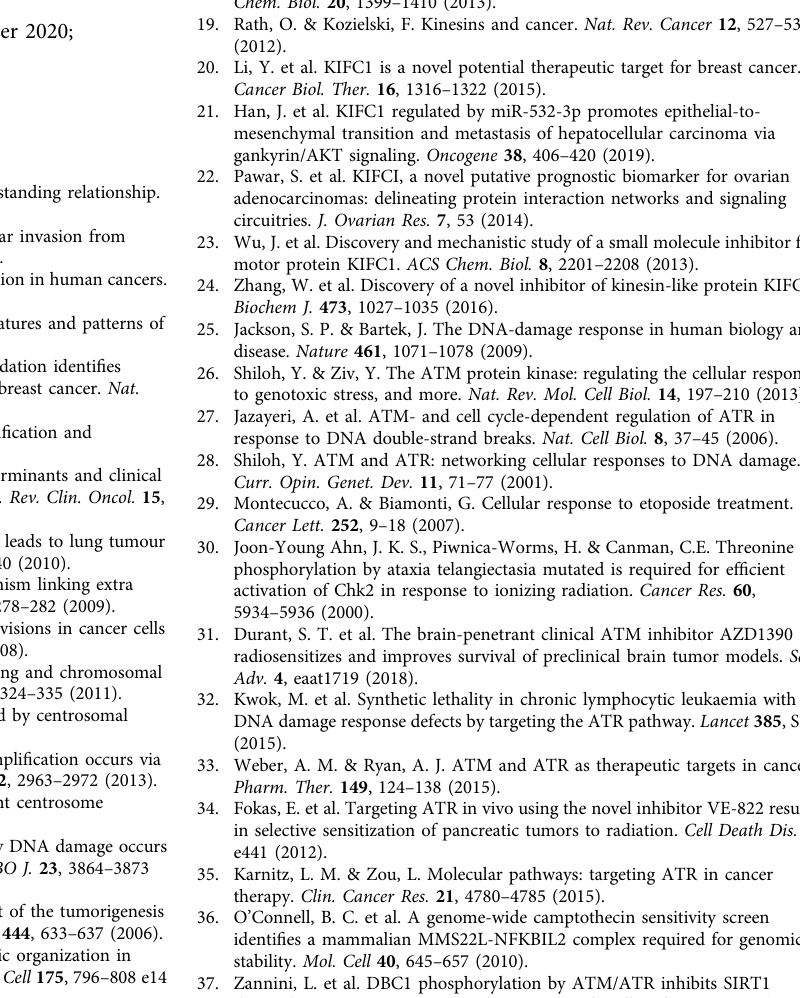
Fig. 8 The ATM/ATR-KIFC1-centrosome clustering pathway promotes tumor recurrence. a Schematic drawing of tumor recurrence, as described in the Methods section. Xenograft tumors were treated with etoposide alone and in combination with PBS, VE-822, or CW069, and were allowed to grow up to a mean volume of 300 mm 3 before being surgically resected. After surgery, the mice were treated with the indicated drugs for another 2 weeks. After 5 months with no drug treatment, mice with tumor recurrence were identi fi ed and analyzed. b The time at which the indicated tumors reached 300 mm 3 . Data represent mean ± SD ( n = 10). Two-tailed t test p values (from left to right): p = <0.00001 and <0.00001. c, d KIFC1-S26 phosphorylation promotes CIN in xenograft tumors. The indicated cells were isolated from the surgically resected tumors and then were cultured to assess the rate of CIN in vitro. For each experimental condition, 100 – 150 cells were counted, and three independent experiments were performed. c The graph shows the fraction of indicated cells with different numbers of chromosomes per cell. For each experimental condition, 100 – 127 cells were counted, and three independent experiments were performed. Two-tailed t test p values (from left to right): p = 0.0022, 0.0035, 0.0021, and 0.0008. d The graph shows the fraction of the indicated cells stained for centromeric DNA on chromosomes 3 and 7 with FISH analysis. For each experimental condition, 100-124 cells were counted, and three independent experiments were performed. Two-tailed t test p values (from left to right): p = 0.0092 and 0.0077. e Graph depicting the Kaplan-Meier analysis of tumor recurrence in the different groups. Survival cutoff criteria (compassionate euthanasia), when the recurrent tumors impeded ambulation, defecation, urination, or eating. Each group, n = 10. Two-tailed t test p values (from left to right): p = 0.0442 and 0.0291. f Representative images showing local recurrence and distant recurrence (lung metastases). The boxed enlargements showed tumor morphology. Hematoxylin and eosin staining of tumor tissue sections. g, h KIFC1-S26 phosphorylation promotes CIN in the locally recurrent tumors. Recurrence-WT (Rec-WT) and recurrence-S26D (Rec- S26D) cells were isolated from the indicated recurrent tumors and then were re-cultured to assess the rate of CIN in vitro. The untreated cells were MDA- MB-231 cells. Data represent the mean ± SD of three times of independent experiments. For each experimental condition, 100 – 109 cells were counted, and three independent experiments were carried out. g The graph shows the fraction of indicated cells with different numbers of chromosomes per cell. For each experimental condition, 100 – 109 cells were counted, and three independent experiments were performed. Two-tailed t test p values (from left to right): p = 0.0022, 0.0031, 0.0079, and 0.0024. h The graph showed the fraction of the indicated cells stained for centromeric DNA on chromosomes 3 and 7 with FISH analysis. For each experimental condition, 100 – 159 cells were counted, and three independent experiments were performed. Two-tailed t test p values (from left to right): p = 0.0261, 0.0098,0.0047, and 0.0164. * p < 0.05; ** p < 0.01. Source data are provided as a Source Data fi